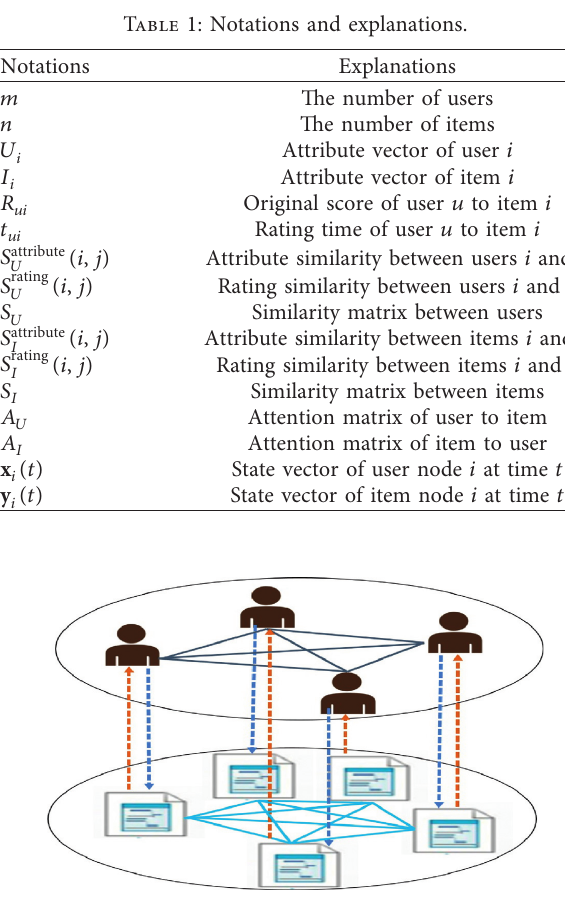
Figure 1: Double-layer network